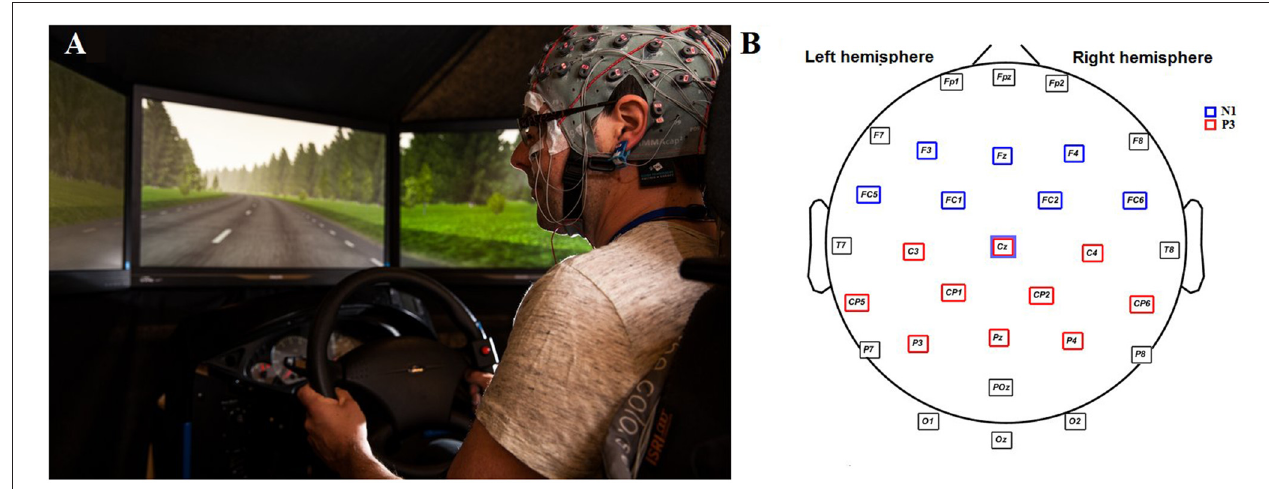
FIGURE 1 | On the left (A) , a picture of one participant before the onset of the experiment. Explicit written consent for publishing this image was given by the participant. On the right side (B) , an illustration of the 30 scalp electrodes recorded and sets of electrodes analyzed for N1 (blue squares) and P3 (red